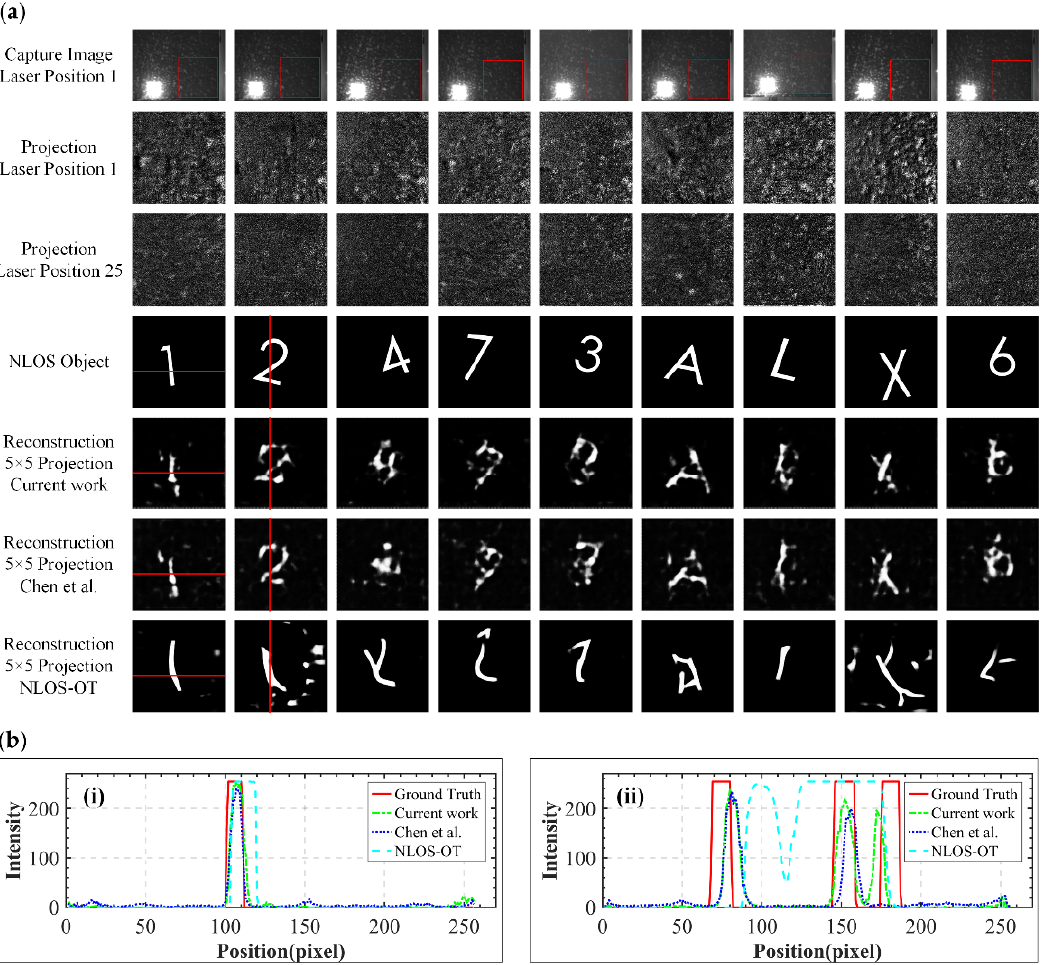
Figure 7. ( a ) Comparison of the reconstruction results of the test targets on the captured data; ( b ) intensity plots from a line profile of the objects, where image ( i ) and image ( ii ) represent the pixel intensity along the red line in the digital “1” and “2” images, respectively.